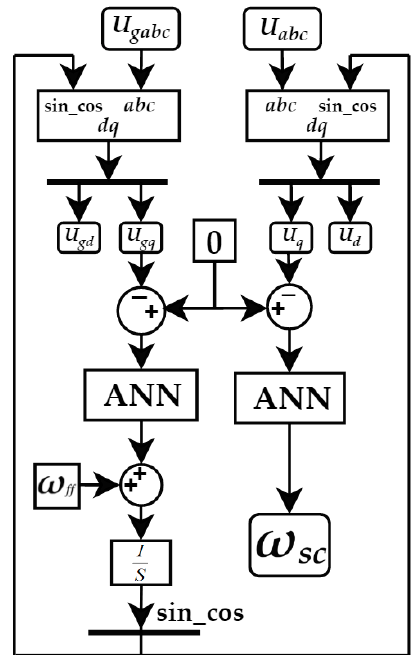
Figure 11. The pre-synchronization control algorithm. ANN: artificial neural network.